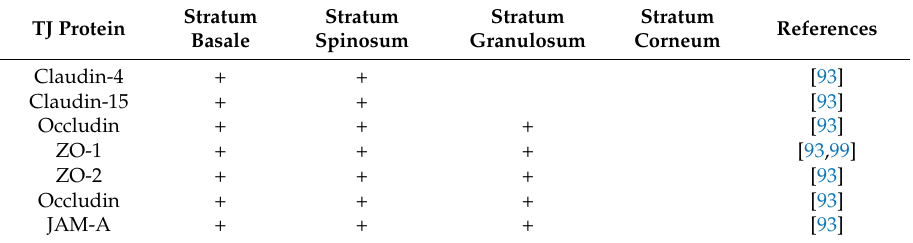
Table 2. Distribution of bi-cellular tight junction proteins in human oral mucosa. Stratum Stratum Stratum TJ Protein Basale Spinosum